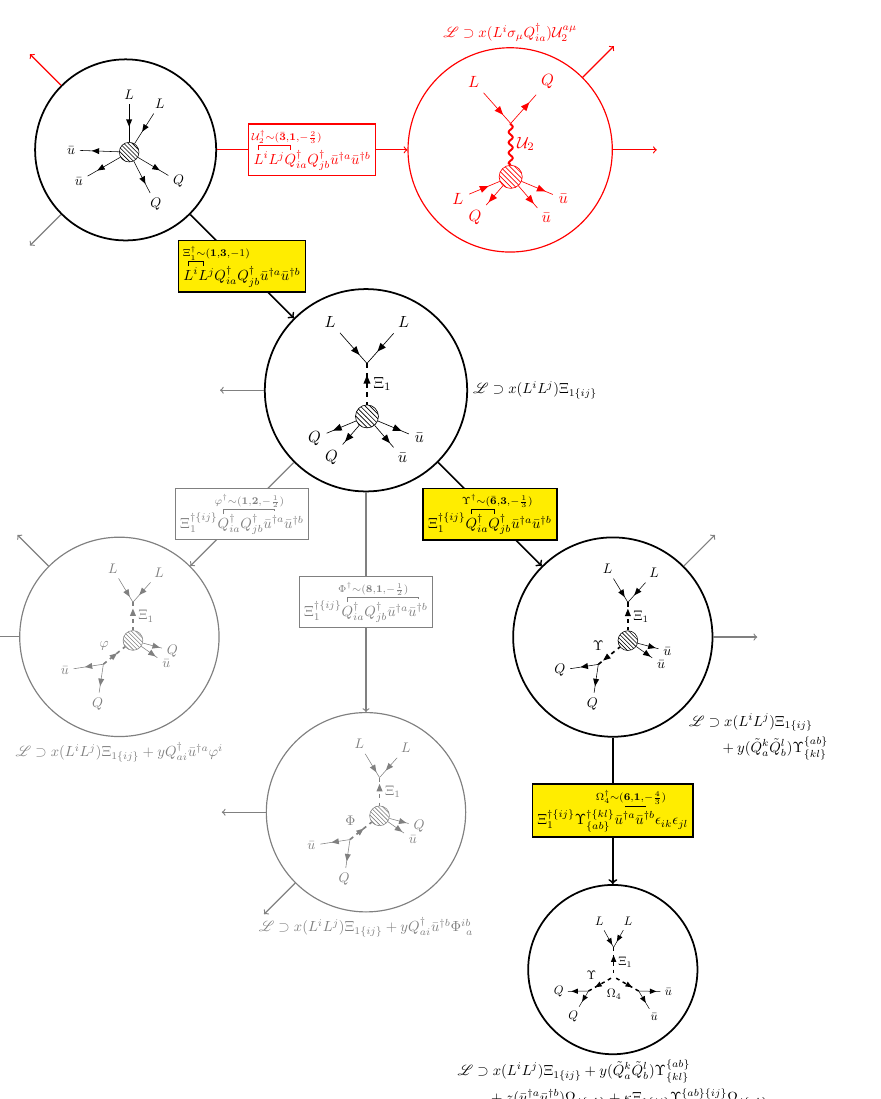
Figure 3. The graph visualises our completion procedure by showing some of the possible ways to explode the operator O 12 aδ = L i L j Q † Q † ¯ u † a ¯ u † b . The options are only followed to a fully UV- ia jb complete model on one branch, shown in bold with yellow edge labels. In each step groups of fields are contracted at a vertex, fixing the properties of the exotic field as well as the structure of the term describing the interaction, shown alongside each diagram. The effective operator is gradually opened up until each vertex in the diagram corresponds to a term with mass-dimension d ≤ 4 . Opening up the operator fully requires repeating this procedure for all possible contractions. In this case this includes other scalar-only completions and scalar-plus-fermion models. We also show steps that we choose to forbid in our approach in red, like the vector contraction giving rise to the vector leptoquark U 2 in the figure. Flavour indices have been